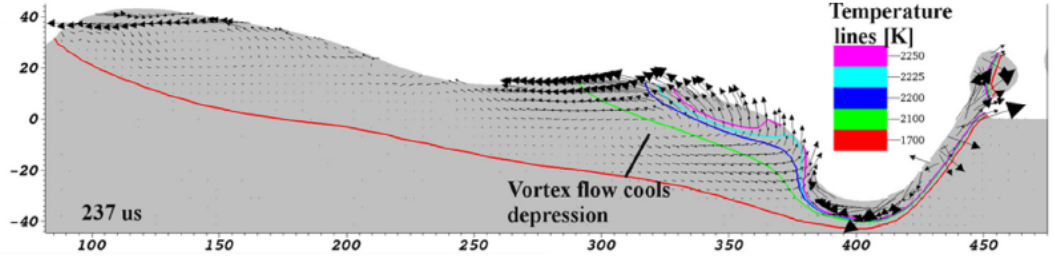
Figure 8. Longitudinal visualization of the laser track